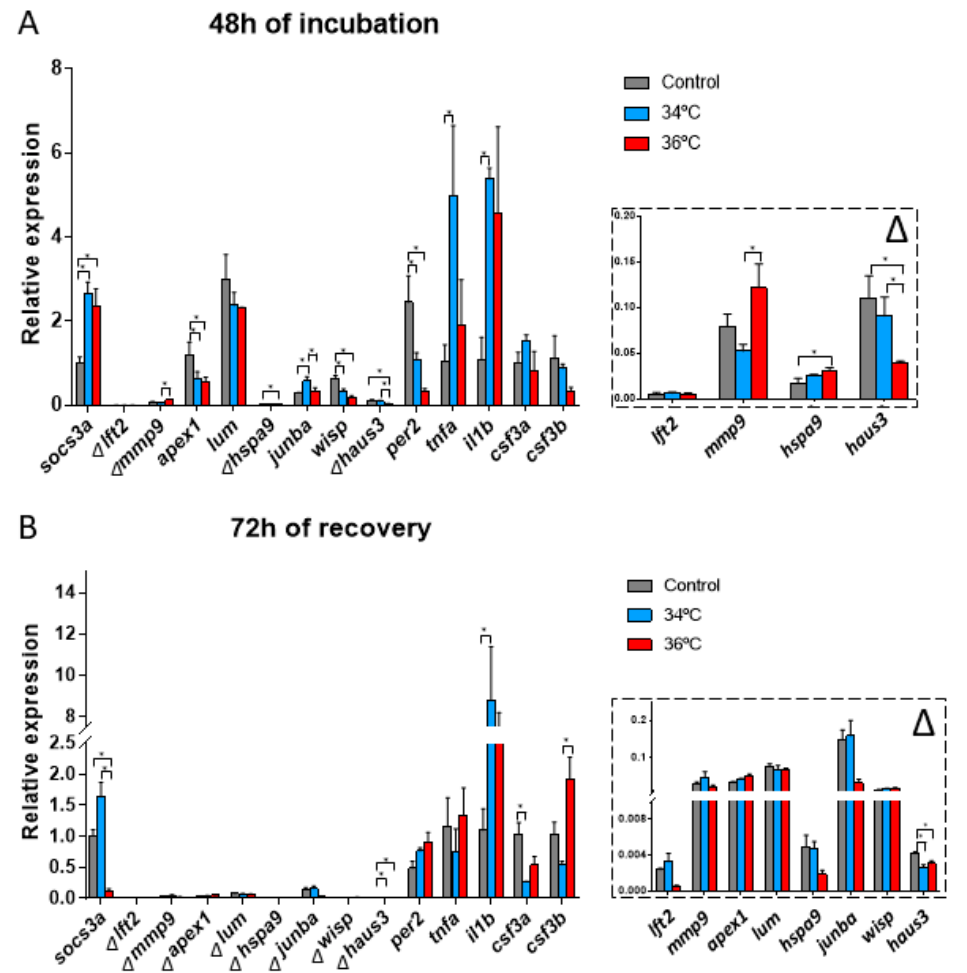
Figure 4. Embryo gene expression analyzed by qPCR after incubation at 28 °C, 34 °C, and 36 °C for 48 h ( A ) and for 48 h plus 72 h recovery at 28 °C ( B ). N = 10 embryos/temperature and time point in triplicate. One-way ANOVA was performed, and differences were considered significant when * p < 0.05. ∆ = in the detailed view of marked genes.